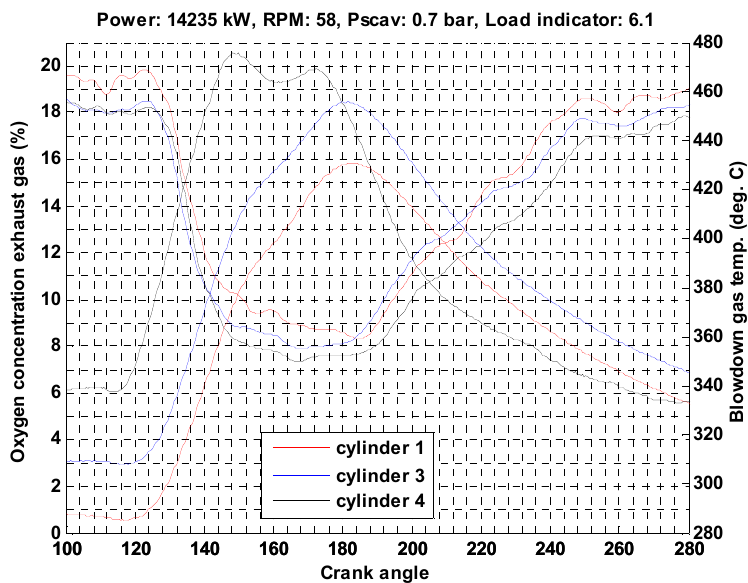
Figure 10. Oxygen and exhaust gas temperature signature with early closing of the exhaust valve vs. crank angle degrees (aTDC).